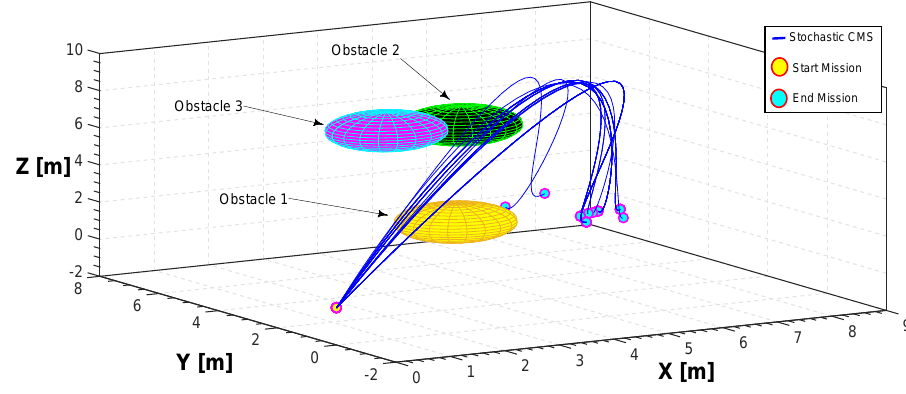
Figure 18. Stochastic complex maneuvering in 3D space (CMS).